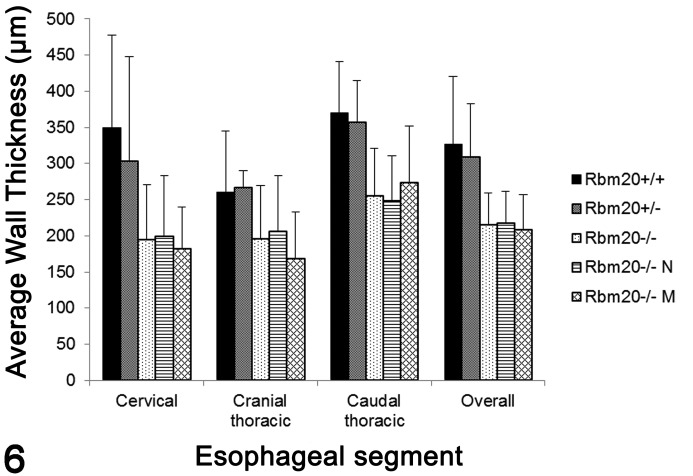
Average esophageal wall thickness shown by segment for rats of all Rbm20 genotypes.
“Rbm20–/–” indicates all genotypically null animals, “Rbm20–/–
N” indicates genotypically null rats with esophagi of ≤5 mm, and “Rbm20–/– M”
indicates genotypically null rats with megaesophagus. The average thickness of the
esophageal wall among all Rbm20–/– rats was
194.4 ± 76.2 μm in the cervical portion, 195.6 ± 74.1 μm in the cranial thoracic
portion, and 255.6 ± 65.3 μm in the caudal thoracic portion (n = 18). Standard deviations are depicted. n =
2 for Rbm20+/+ rats; n = 3 for Rbm20+/– rats; n = 13 for Rbm20–/– N
rats, and n = 5 for Rbm20–/– M rats.